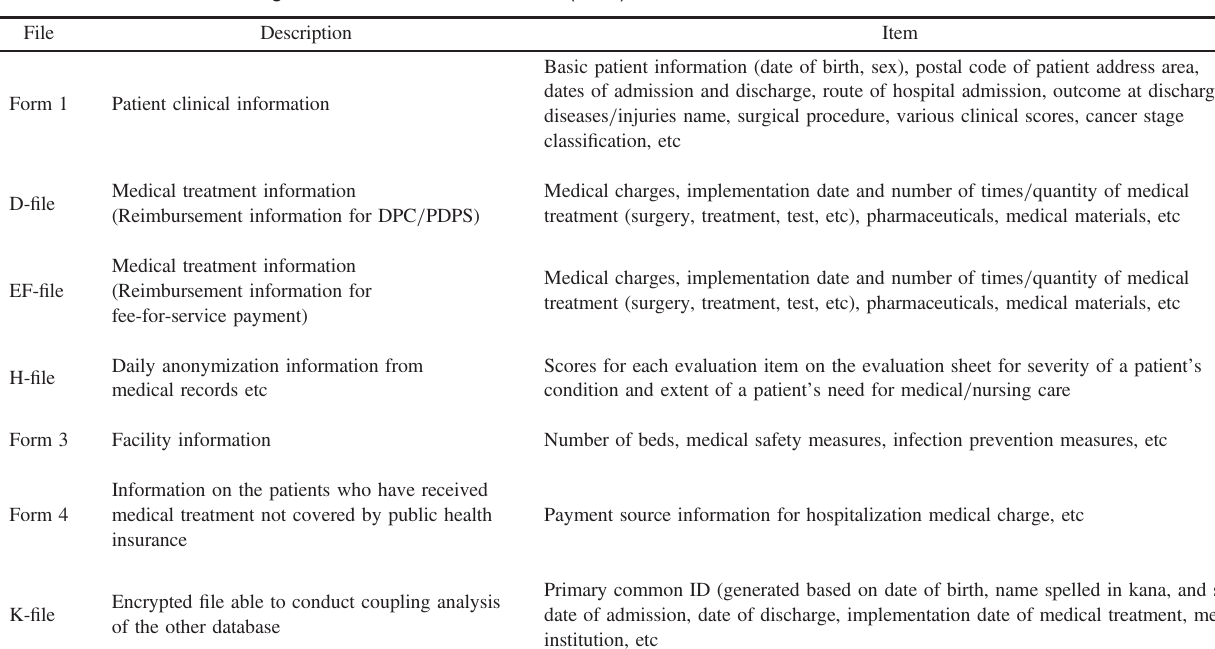
Table 4. Data related to Diagnosis Procedure Combination (DPC) File